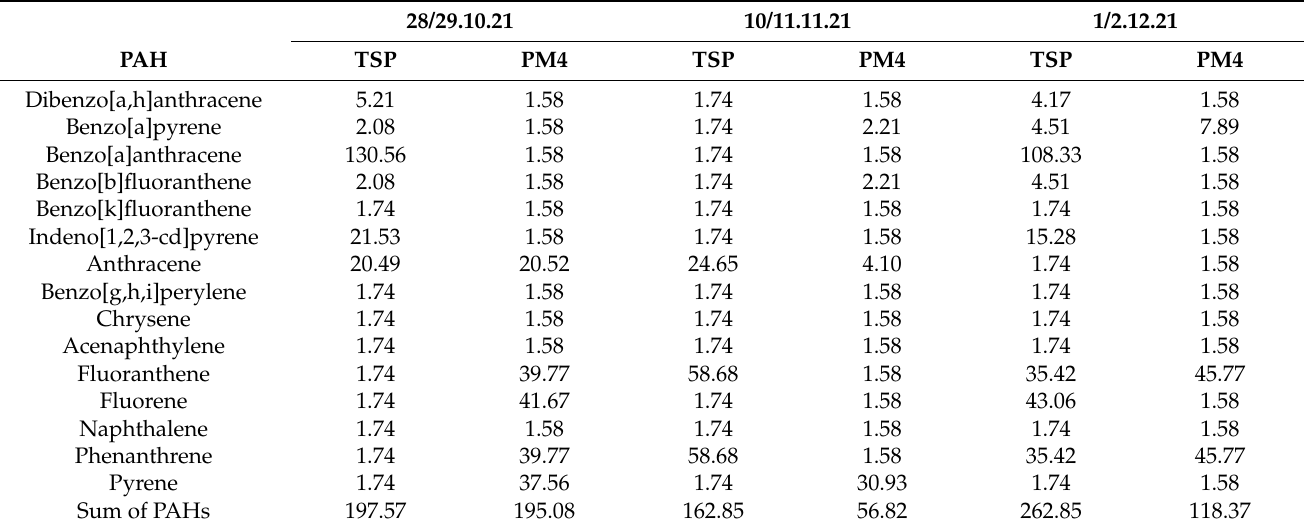
Table 4. The concentration of individual PAHs (ng/m 3 ) in TSP and PM4 samples collected in the garage of the fire station